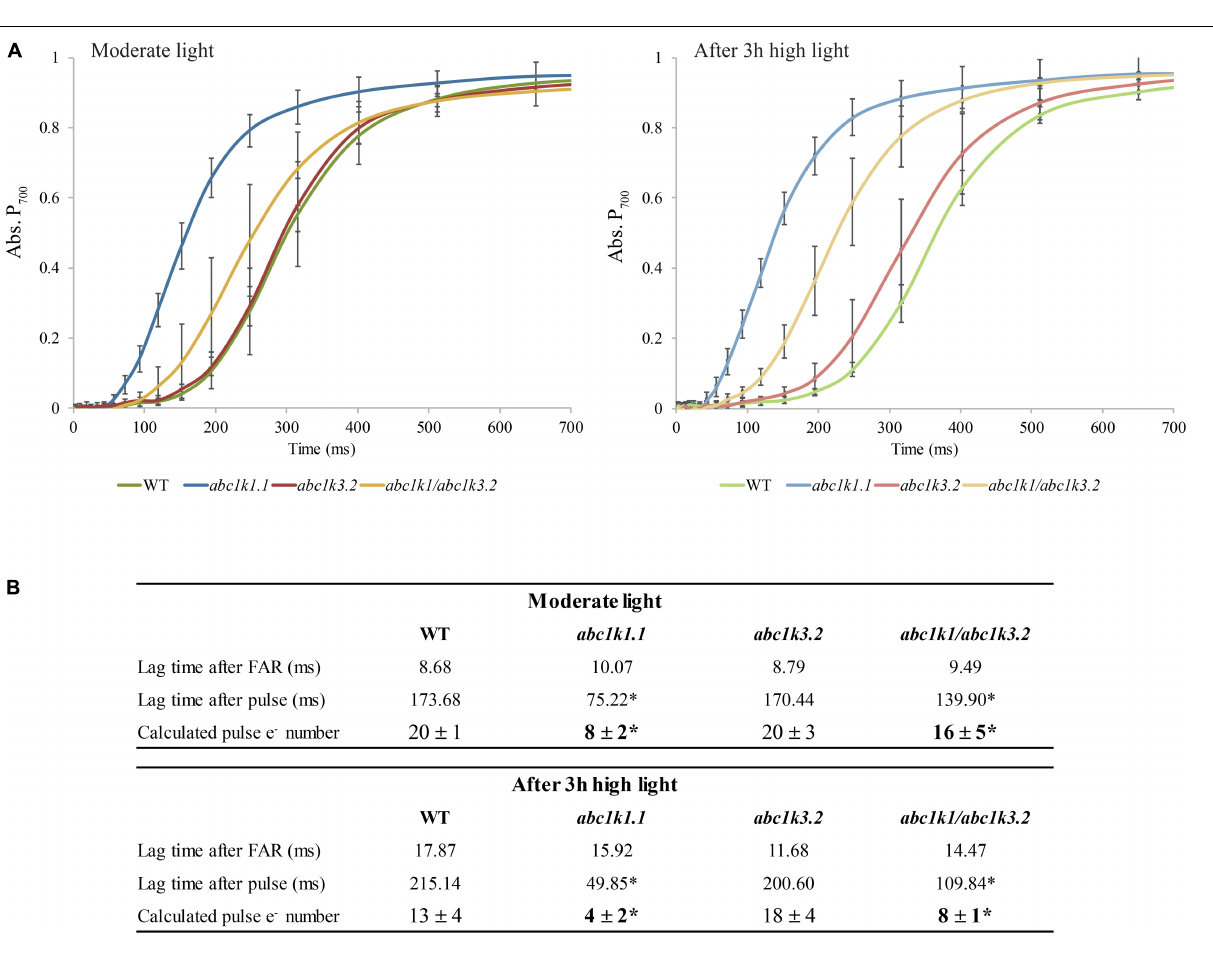
FIGURE 3 | The shortage of electron carriers per photosystem I of abc1k1 is partially recovered in abc1k1/abc1k3 . (A) Kinetics of P 700 re-oxidation induced by far-red light were recorded after a saturating light pulse (Time 0 = far-red ON) in wild type, abc1k1.1, abc1k3.2, and abc1k1/abc1k3.2 kept under moderate light and after 3 h of high light. The P 700 oxidation status was measured by the increase in absorption at 810 nm on fully expanded leaves of each genotype. (B) Electron (e − ) carried by the electron transport chain per photosystem I calculated from the lag time of P 700 oxidation after a saturating pulse divided by the lag time of the oxidation after dark. Asterisk are used to indicate statistically different groups by Student’s t -test ( p < 0.05) ( n = 4 biologically independent